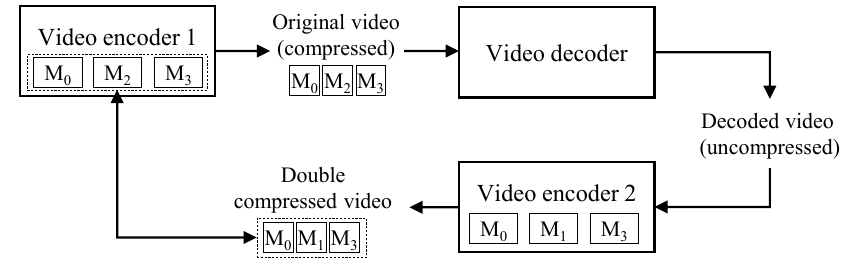
Figure 2. Key idea of the proposed